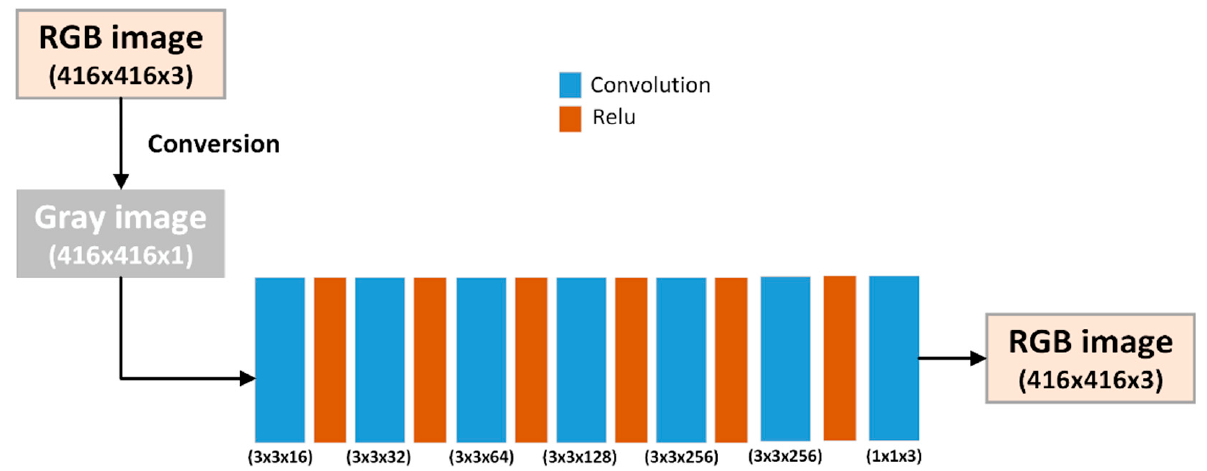
Figure 3. Dense convolutional neural network (DCNN) architecture. The architecture only consists of a sequence of 3 × 3 Convolution and Relu layers. Table 2. Comparison between UNet, UNet-22, UNet-54, Xception–UNet, and DCNN based on the PSNR, SSIM, and LPIPS in the colorization task. The best values of PSNR are 33.637, SSIM is 0.9706, and LPIPS is 0.0144.